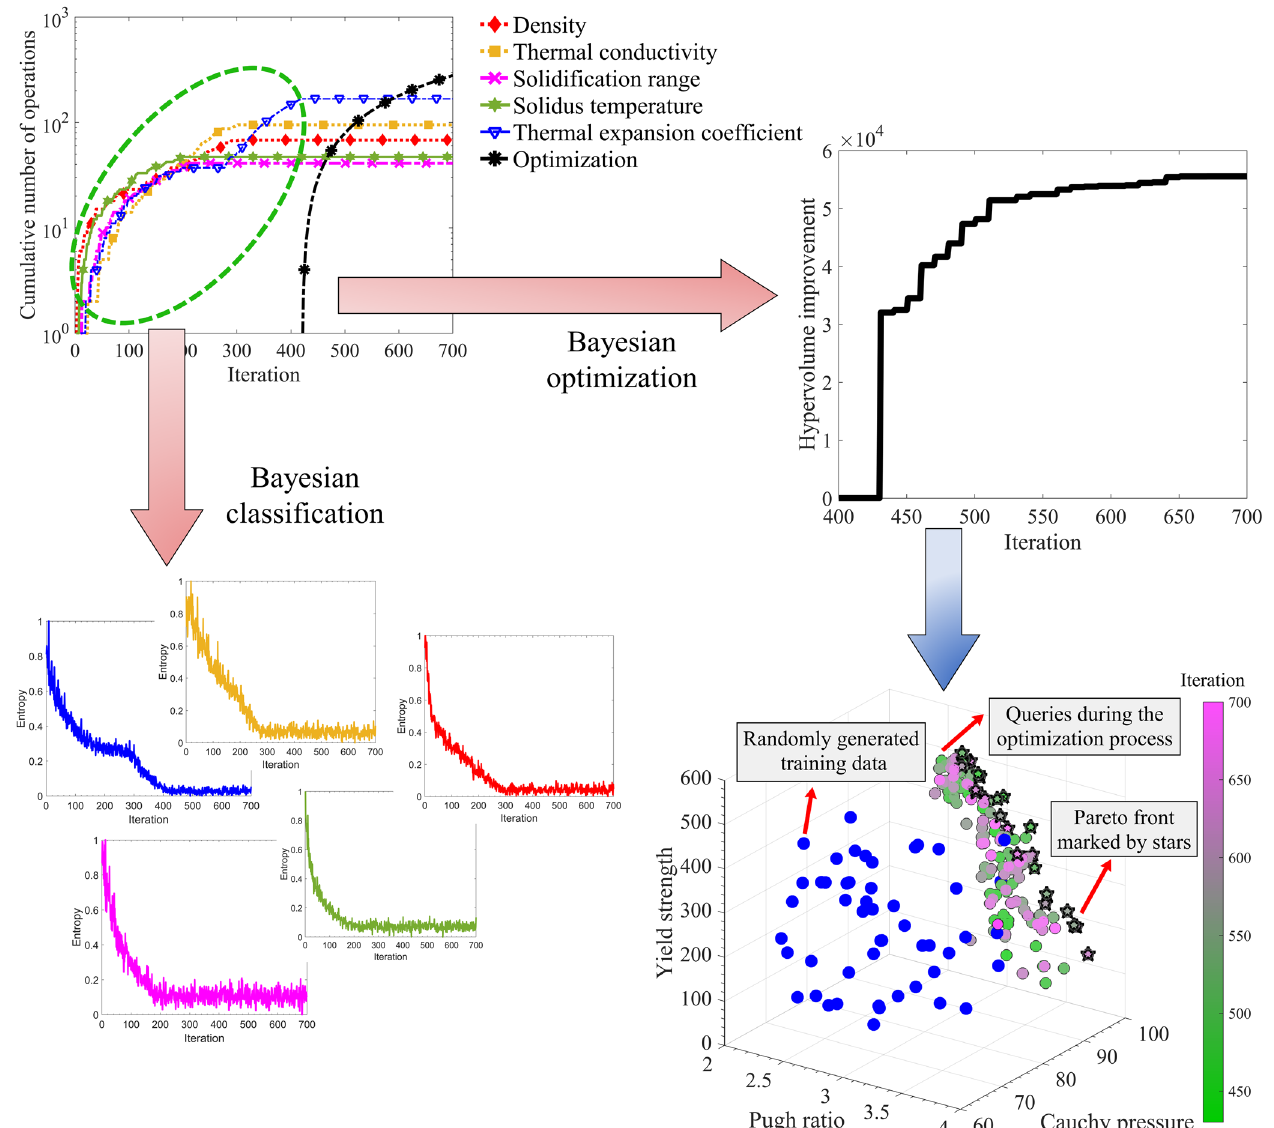
Fig. 2 Overall results of the 5-constraint 3-objective material design problem. The fi gure shows the application of the proposed framework to solve the problem. The process begins with learning the constraint boundaries by querying the constraints, effectively reducing the entropy associated with each classi fi er that represents a speci fi c constraint. Once the entropy curves for all classi fi ers are fl attened, Bayesian optimization begins to learn the non-dominated design region. As the estimations of the Pareto front improve, the hypervolume increases respectively. The fi gure also includes an illustration of the objective space, showing all the queries to the ground truth model and the fi nal estimation of the Pareto